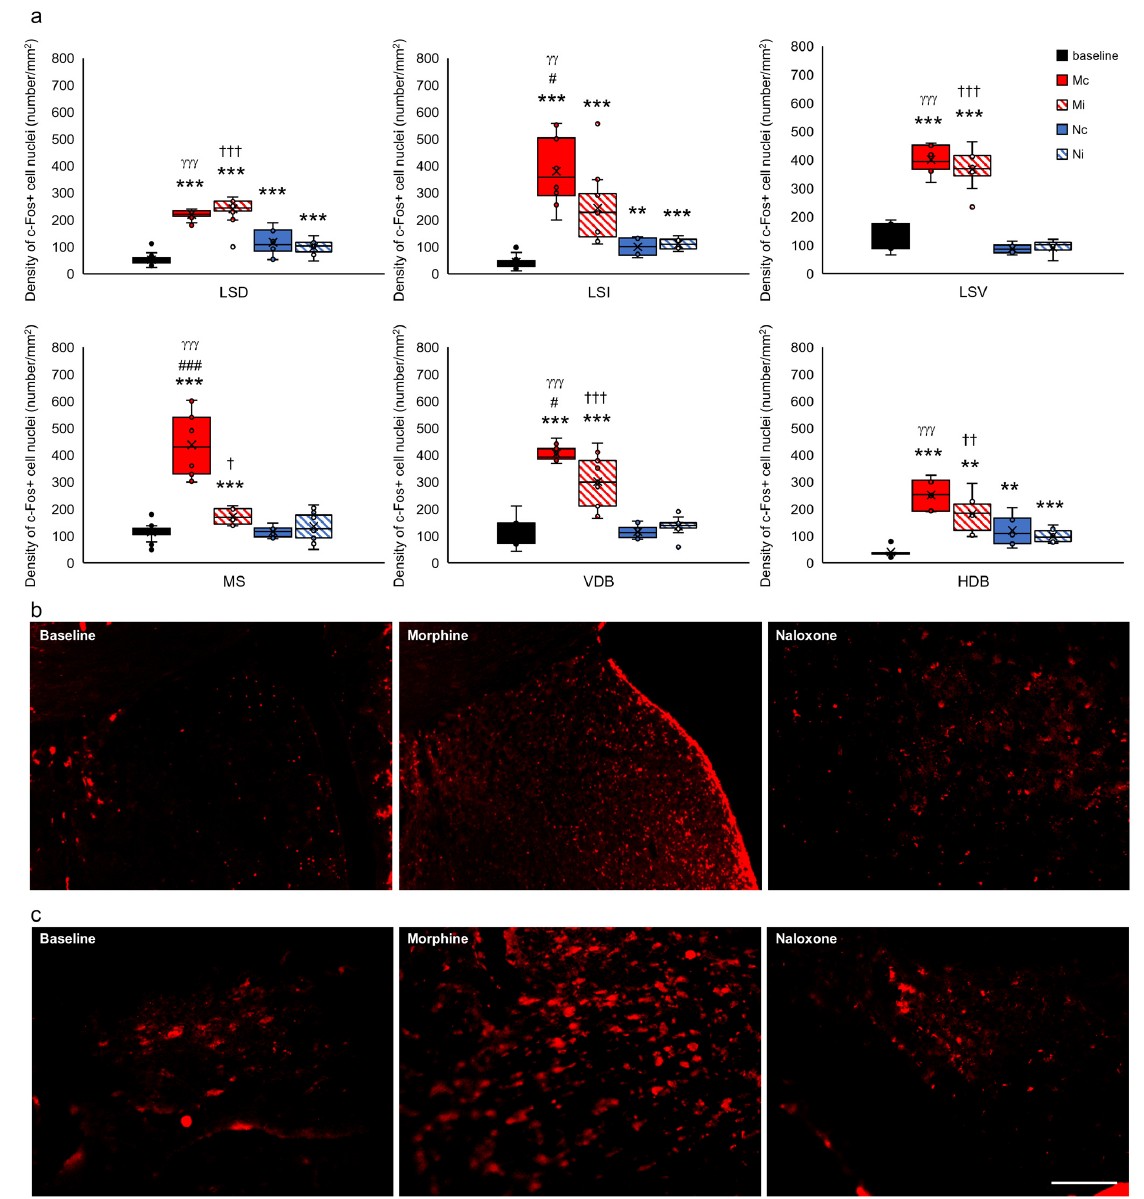
Figure 8. Density of c-Fos+ cell nuclei (number/1 mm 2 ) in select structures of the septal system in the brains of rats that were subjected to VTA electrical stimulation (Es-VTA) only (baseline group, n = 5) (black-filled bars) and in the brains of rats administered Es-VTA and a one-time injection of morphine (1.5 µ g) or naloxone (25.0 µ g) injected into the PPN in the contralateral (Mc, n = 5, red-filled bars; Nc, n = 6, blue-filled bars) and ipsilateral hemispheres (Mi, n = 5, red-hatched bars; Ni, n = 6, blue-hatched bars) ( a ). Representative photomicrographs of c-Fos-labeled neurons in the LSD ( b ) and VDB ( c ) structures are shown. Scale bar = 100 µ m (white line: right lower corner of the last photo, panel ( c )). Tukey’s post hoc test: ** p < 0.01, and *** p < 0.001 indicate a significant difference between the baseline and other experimental groups (Mc, Mi, Nc, and Ni groups); # p < 0.05, ### p < 0.001 indicate a significant difference in the morphine groups between different injection site: contra- or ipsilateral hemispheres (Mc vs. Mi group); γγ p < 0.01, γγγ p < 0.001 indicate a significant difference in the contralateral side groups between different injection drug: morphine or naloxone (Mc vs. Nc group); † p < 0.05, †† p < 0.01, ††† p < 0.001 indicate a significant difference in the ipsilateral side groups between different injection drug: morphine or naloxone (Mi vs. Ni